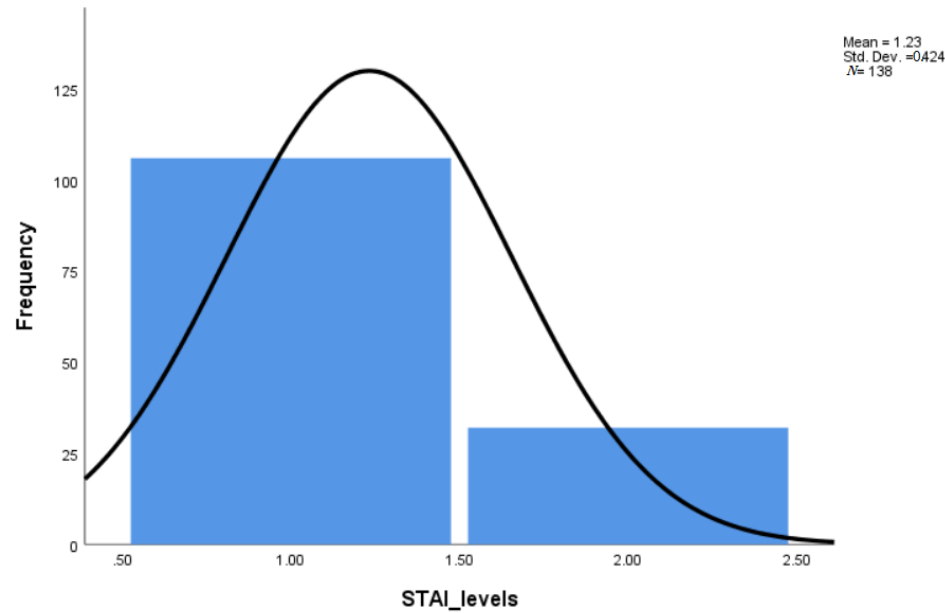
Figure 1. The pre-scan anxiety scores.